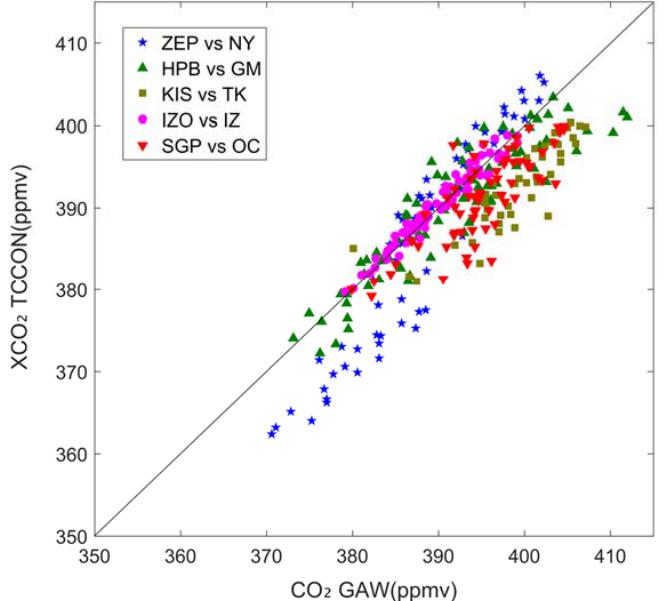
Figure 7. Validation of TCCON monthly average retrieval results with observational flask CO 2 concentration from GAW surface locations: Zeppelinfjellet (ZEP) site vs. Ny Alesund (NY) station ( ★ ), Hohenpeissenberg (HPB) site vs. Garmisch (GM) stations ( ▲ ), Kisai (KIS) site vs. Tsukuba (TK)